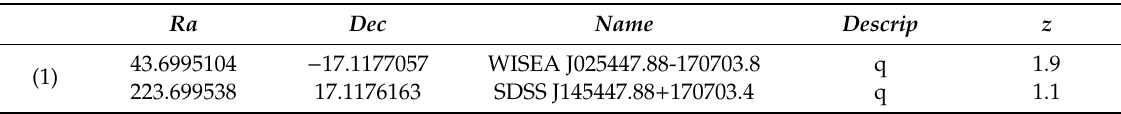
Table 14. Pair of quasars from Milliquas 6.3 catalog with the best positional accuracy for mirror e ff ect—alternative approach. Accuracy is of 0.0001 ◦ for ra and dec and z / 2 for z . Descrip column is the classification of object, see [47]. Redshift z is given, although not essential